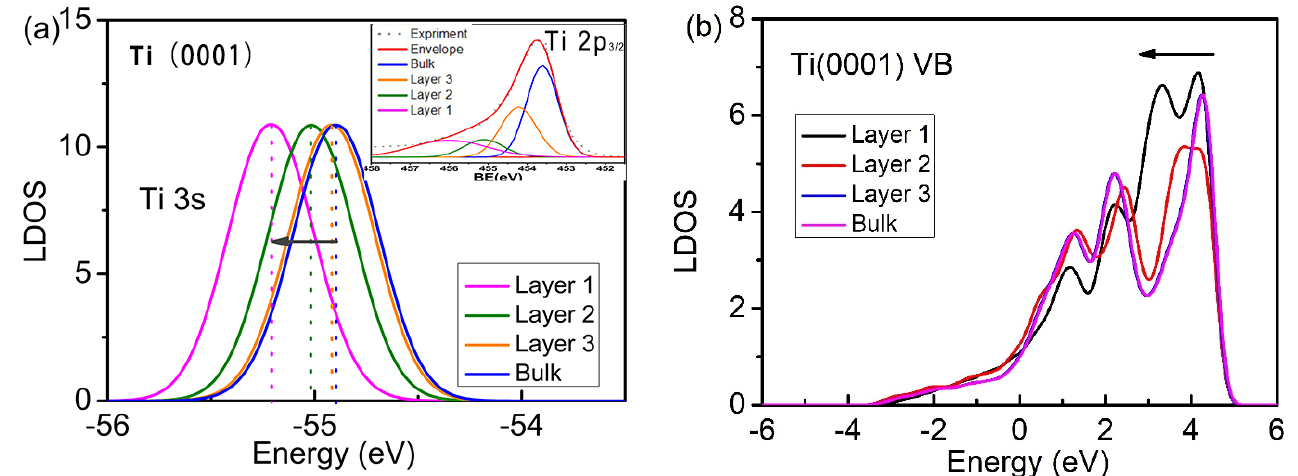
Figure 3. Layer-resolved LDOS of Ti3s ( a ) and valence band ( b ) of the Ti(0001) clean surface. Arrows indicate a shift in binding energy to deeper energy levels as the coordination number decreases, i.e., quantum entrapment. (a, inset): experimentally determined layer-resolved XPS resolution spectrum of the Ti2p core level. The energy shift of each component is proportional to the magnitude of bond energy according to the following relation: ∆ E v ( i ) / ∆ E v ( 12 ) = E i / E B = C − m